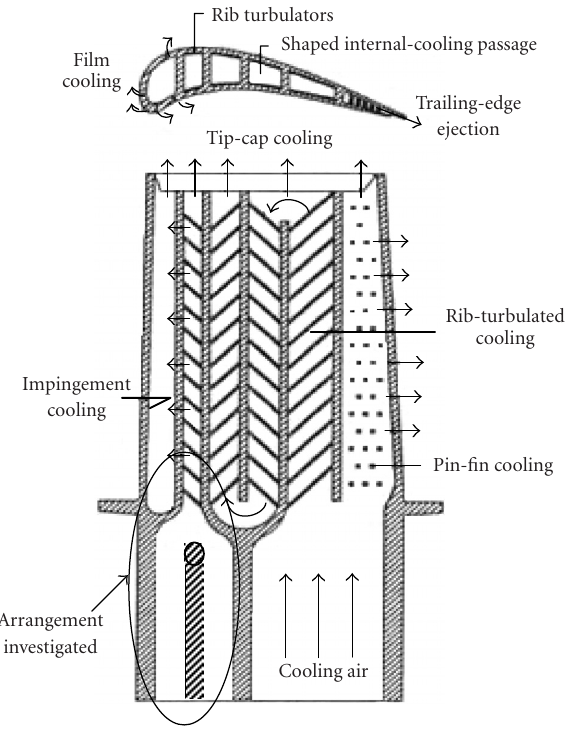
Figure 1: Cross-sectional view for the internal-cooling channels of a typical blade